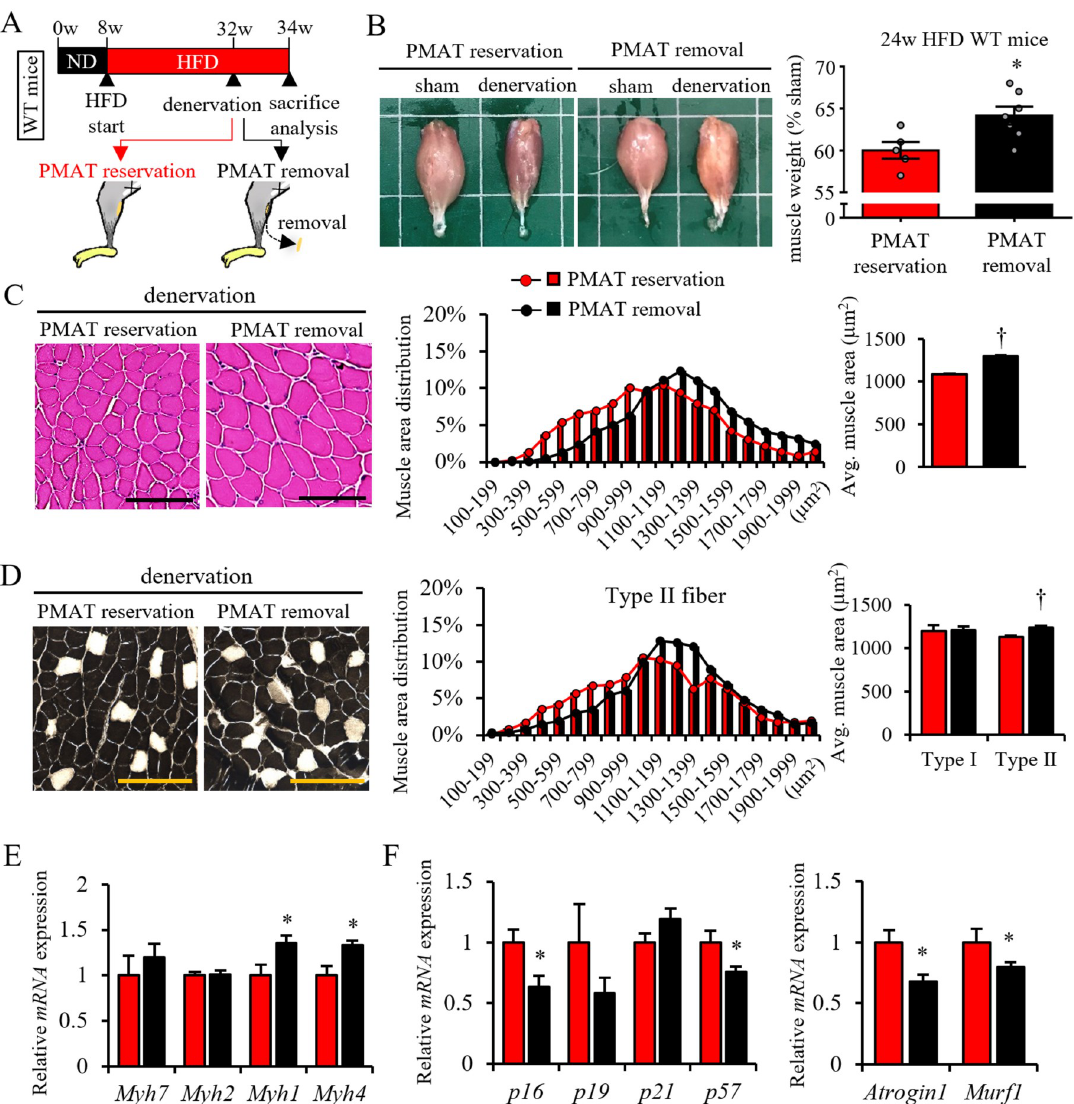
Fig 6. PMAT removal from obese mice protects against skeletal muscle atrophy. (A) Schematic showing protocol for sciatic denervation with or without PMAT resection in mice fed a HFD for 24 weeks. (B) Shown are representative samples of gastrocnemius (left panels) plus quantification (right panel) of tissue weight relative to sham (shown as a %) in mice with or without PMAT resection after 2 weeks of denervation or sham operation. (C) Representative images of muscle HE staining (left panels), calculated distribution (middle panel) and average muscle fiber CSA (right panel) (n = 1200–1500 per group) in the sciatic denervation model with or without PMAT resection. (D) Representative images of muscle ATPase staining (left panels), quantified distribution of type II muscle fibers (middle panel), and the average CSA of type I (black cells in left panels) or type II (white cells in left panels) muscle fibers (right panel) (n = 1200–1500 per group; scale bar, 100 μ m in c and d) from a sciatic denervation model, with or without PMAT resection. (E and F) Relative levels of transcripts marking skeletal muscle myosin subtypes (E), cellular senescence (F, left panel) and protein degradation (F, right panel) in the sciatic denervation model, with or without PMAT resection (n = 6 per group). All data are presented as means ± S.E. Statistical significance was determined by Student’s t-test. � , p < 0.05; †, p <